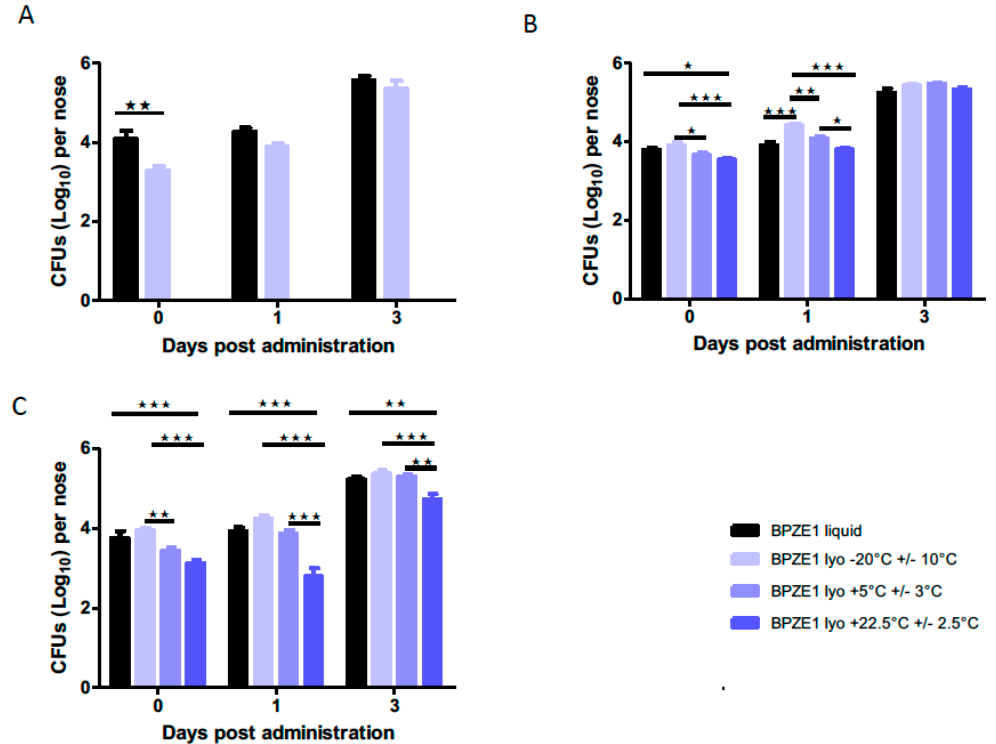
Figure 4. In-vivo colonization kinetics of the lyophilized BPZE1 drug product compared to the liquid drug product. BALB / c mice (n = 5 per group and per time point) were inoculated intranasally with 10 5 CFU of the liquid BPZE1 drug product (black bars) or the reconstituted lyophilized BPZE1 drug product (blue bars) and sacrificed 3 h (day 0), 1 or 3 days thereafter to evaluate the CFU numbers in the nasal homogenates. ( A ) Comparison of the CFU counts of the liquid BPZE1 drug product with those of the lyophilized BPZE1 drug product reconstituted and administered immediately after lyophilization. ( B ) Comparison of the CFU counts of the liquid BPZE1 drug product with those of the lyophilized BPZE1 drug product reconstituted 6 months after storage at − 20 ◦ C ± 10 ◦ C (light blue lines), 5 ◦ C ± 3 ◦ C (middle blue lines) or 22.5 ◦ C ± 2.5 ◦ C (dark blue lines). ( C ) Comparison of the CFU counts of the liquid BPZE1 drug product with those of the lyophilized BPZE1 drug product reconstituted 24 months after storage at − 20 ◦ C ± 10 ◦ C (light blue lines), 5 ◦ C ± 3 ◦ C (middle blue lines) or 22.5 ◦ C ± 2.5 ◦ C (dark blue lines). The results are expressed as means +/ – SEM. *, p < 0.05; **, p < 0.01; ***, p < 0.005; ns, not significant.